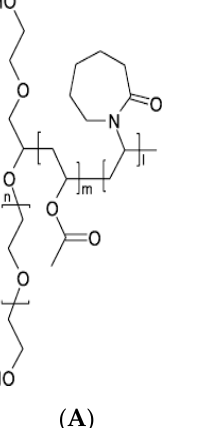
Figure 10. Chemical structure of ( A ) Soluplus ® [79] and ( B ) Kollicoat ® IR [79].